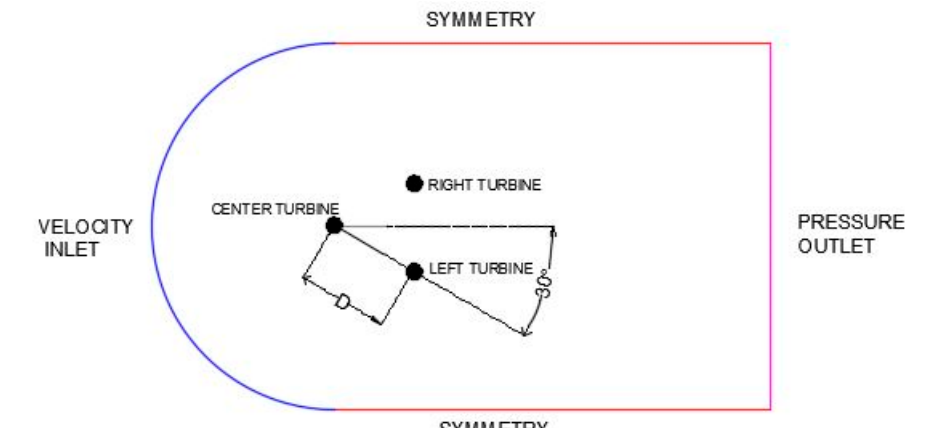
Figure 11. The CFD domain for turbine distance study.